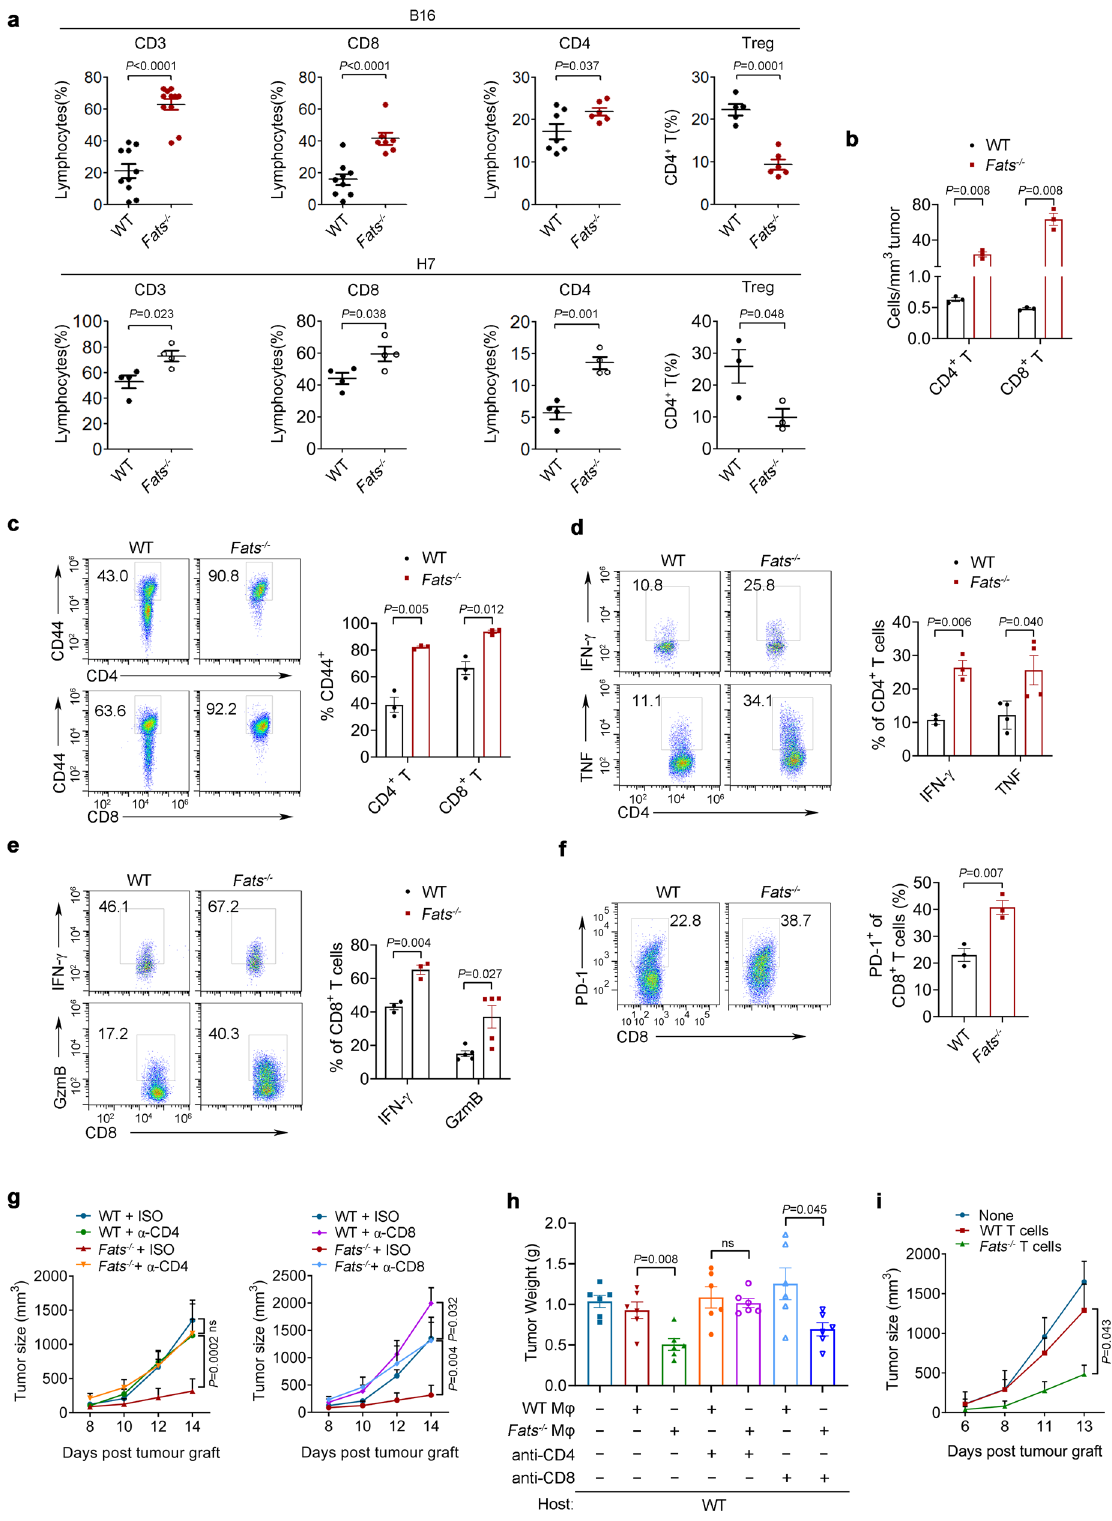
Methods Cell lines and plasmids . The mouse melanoma cells (B16), pancreatic cancer cells (H7), RAW264.7 cells, and human HEK293T cells were obtained from American Type Culture Collection, and authenticated using short tandem repeat pro fi ling. All cells were cultured in DMEM (Gibco) supplemented with 10% FBS (HyClone) and 1% penicillin – streptomycin (Gibco). All cells were cultured at 37 °C in an atmosphere of 5% CO 2 in air. Cells were injected into mice after reaching 60 – 80% con fl uence. Myc-IkBa and HA-UB K48 expression